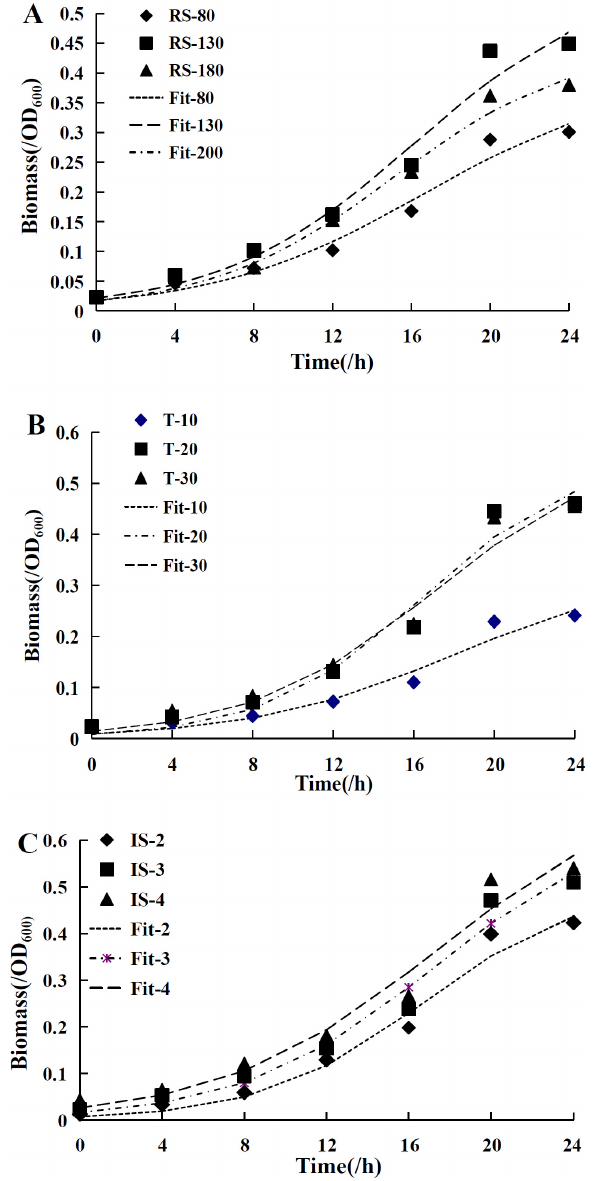
Figure 7. ( A ) is the model fitting of revolving speed relative to biomass, altering variables 80r/min, 130 r/min and 180 r/min, quantifying temperature 30 °C, and inoculum size 3 mL; ( B ) was the model fitting of temperature relative to biomass, altering variables 10 °C, 20 °C and 30 °C, quantifying revolving speed 130 r/min, and inoculum size 3 mL; ( C ) was the model fitting of inoculum size relative to biomass, altering variables 2 mL, 3 mL and 4 mL, quantifying revolving speed 130 r/min and temperature 30 °C.